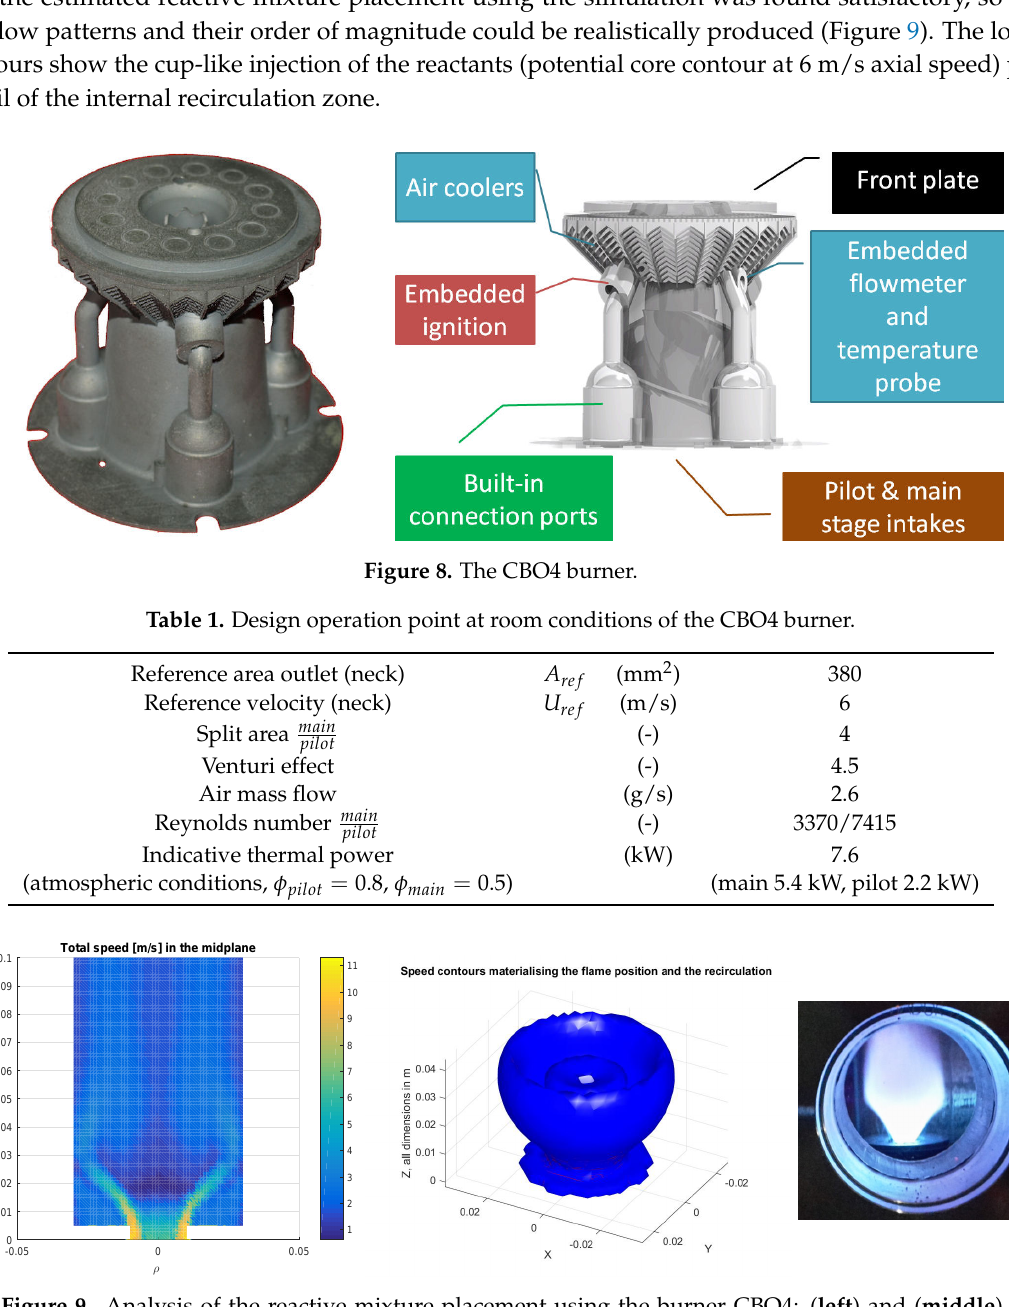
Figure 9. Analysis of the reactive mixture placement using the burner CBO4: ( left ) and ( middle ) nonreactive simulation using openFoam and bottom envelope of the reactive contents plus the internal recirculation zone and ( right ) flame aspect at operating